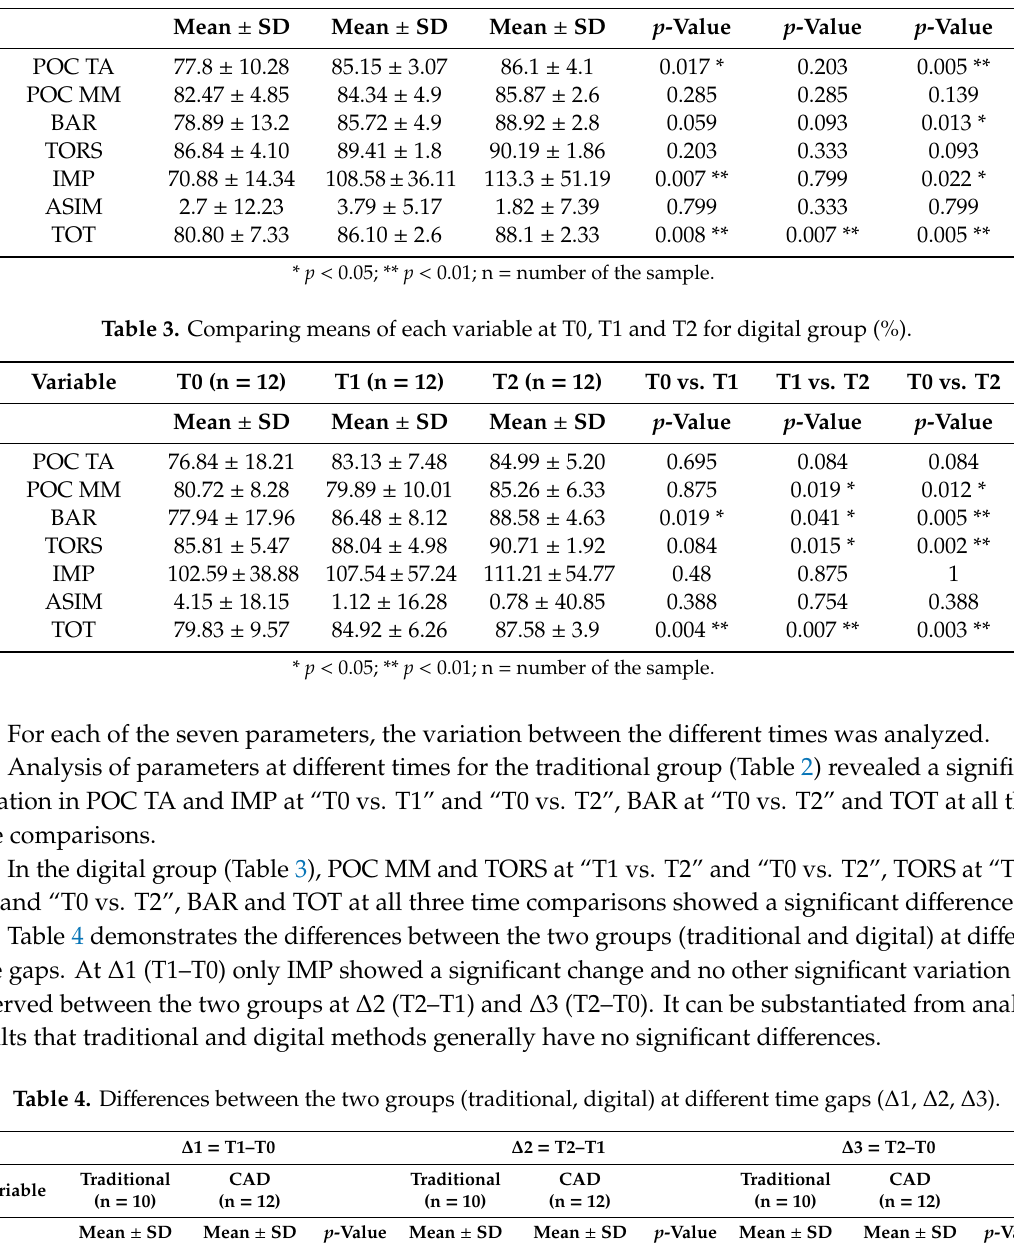
Table 2. Comparing means of each variable at T0, T1 and T2 for traditional group (%). Variable